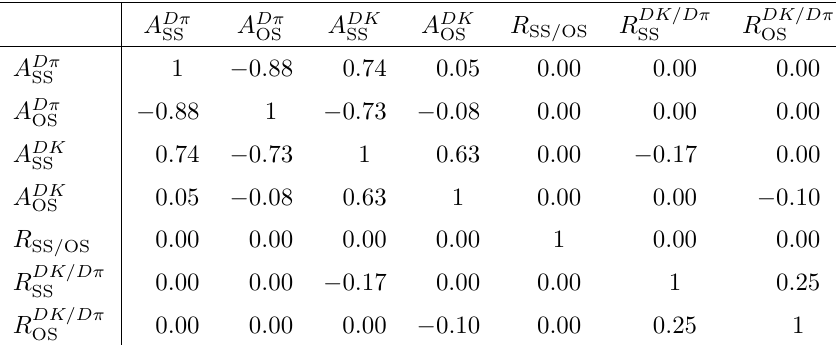
Table 5 . Systematic correlation matrix for the K (cid:3) (892) (cid:6) region (cid:12)t.